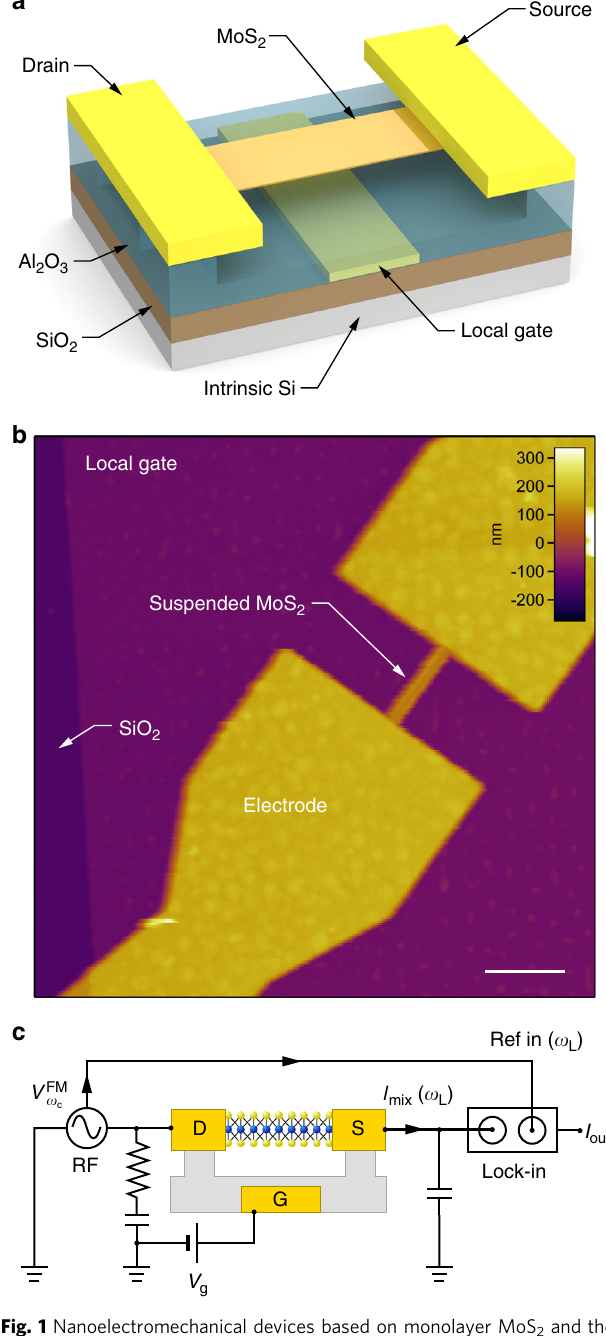
Fig. 1 Nanoelectromechanical devices based on monolayer MoS 2 and the RF electromechanical measurement setup used for characterization of the MoS 2 NEMS resonators. a Schematic of monolayer MoS 2 resonant channel transistor. The implementation of a local gate helps reducing the parasitic effects for high-frequency measurements. The dielectric underneath the MoS 2 sheet is etched resulting in suspended contacts in the clamping region. b AFM image of a monolayer MoS 2 ribbon suspended over a local gate electrode and clamped with source/drain electrodes. Scale bar: 1 µ m. c Schematic illustration of the RF electromechanical measurement setup. A DC voltage is applied to the local gate, and a frequency-modulated voltage (cid:1) (cid:3) V FM sin ð ω L t ÞÞ is applied to the source electrode. The mixing current I mix is detected using a lock-in ampli fi er, locked at the reference frequency ω